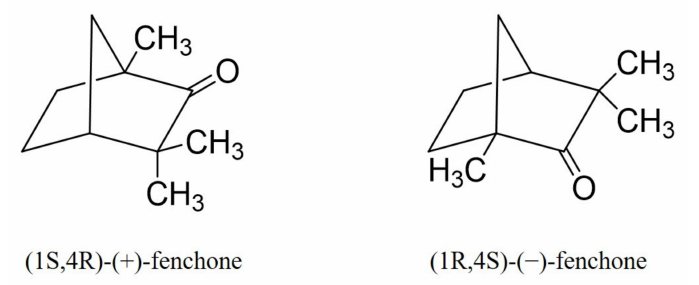
Figure 3. Chemical structures of (1S,4R)-(+)-fenchone and (1R,4S)-( − )-fenchone. Different resorcinols/phenols required different temperatures and reaction times for lithiation and condensation. The (1S,4R)-(+)-fenchone led to (+)-fenchone-resorcinol/-phenol products, while the (1R,4S)-( − )-fenchone led to ( − )-fenchone-resorcinol/phenol products. 20–62% depending on the resorcinol/phenol